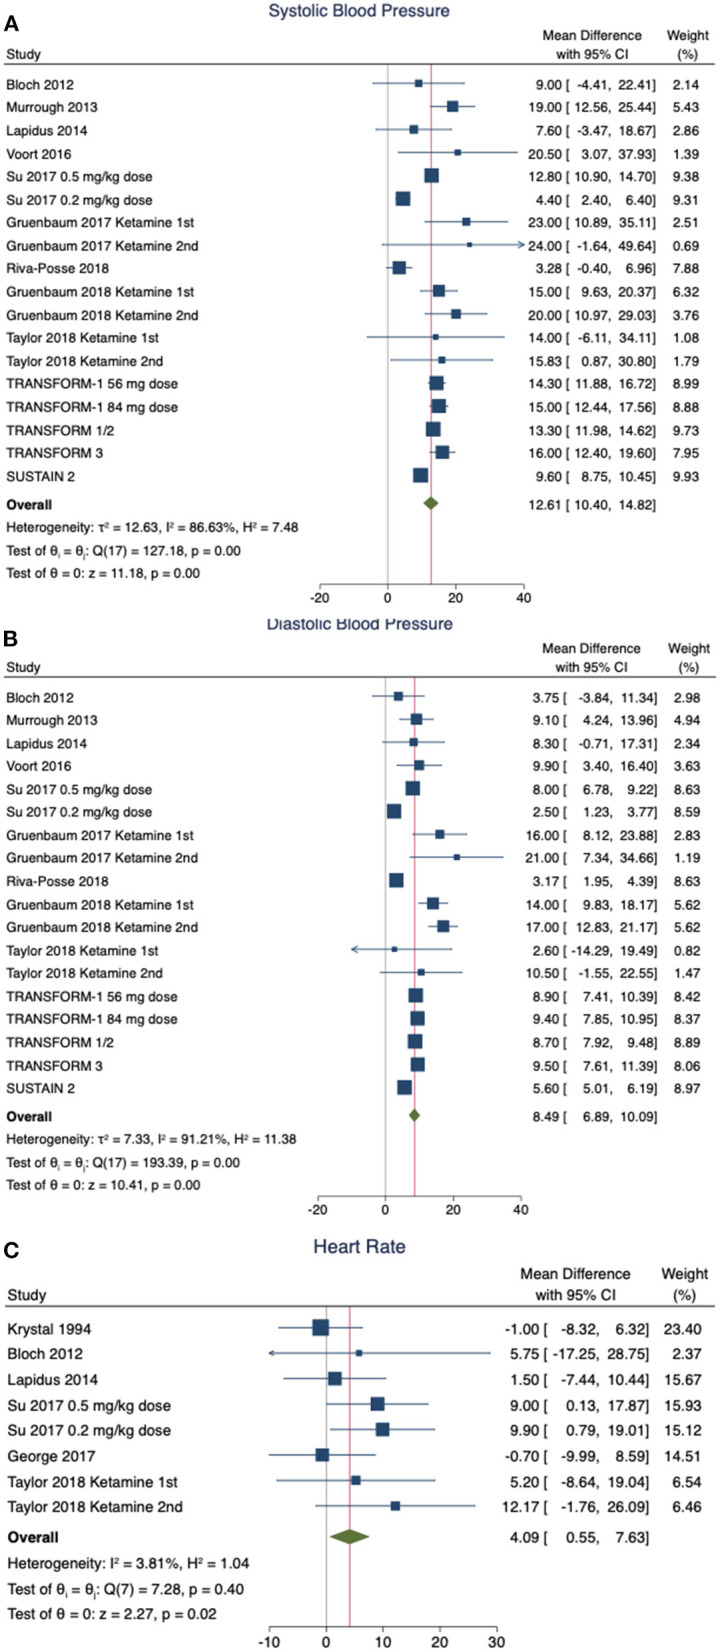
Forest plots. These plots depict pooled effects showing the mean difference in each hemodynamic parameter, and the heterogeneity for pre-post ketamine administration data. Mean and 95%CI are shown for systolic blood pressure (SBP) (A), diastolic blood pressure (DBP) (B), and HR (C). Random effects models were used for (A,B). A fixed effects model was used for (C) due to the low heterogeneity in the HR data.